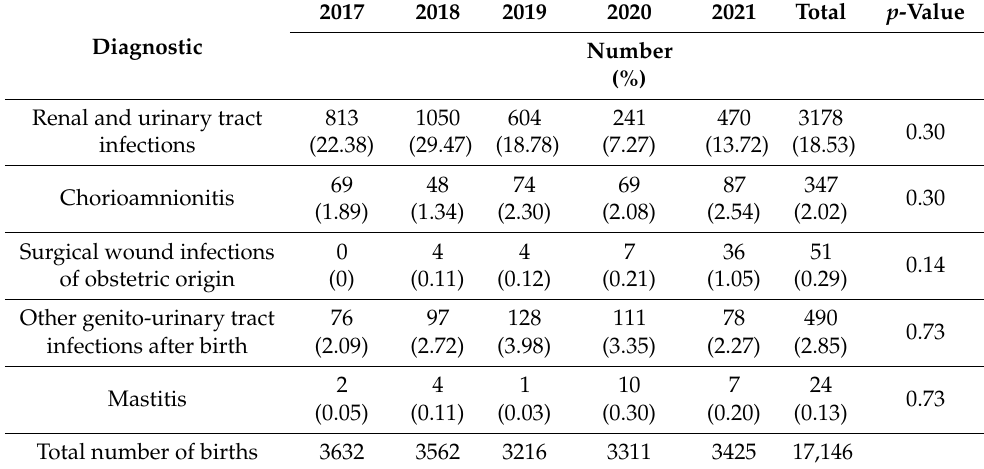
Table 7. Number of patients and infections occurred in between 2017 and